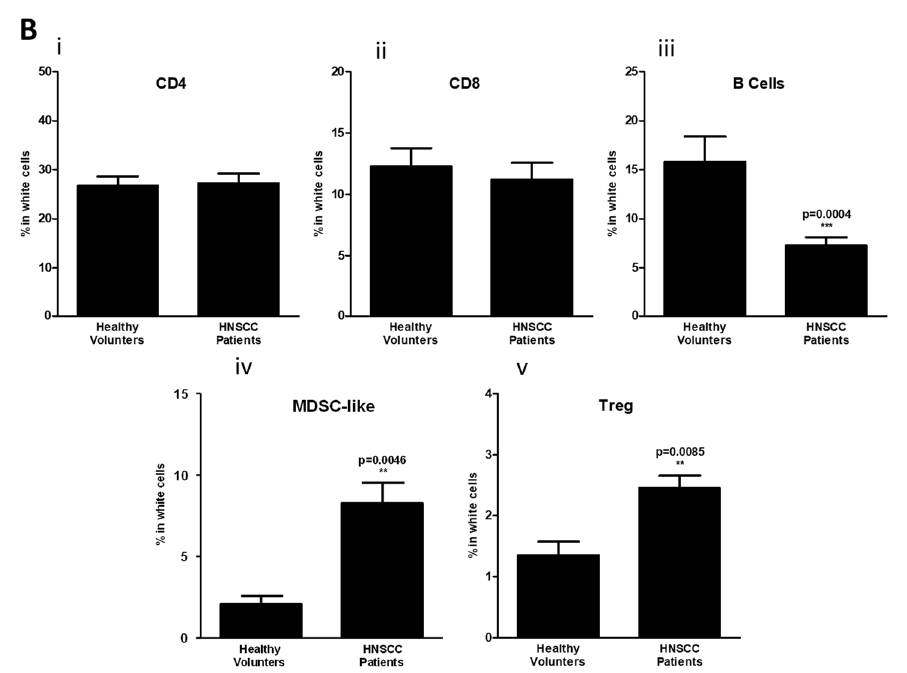
Figure 2. Biospecimen collection and comparison of immunocyte populations in healthy controls and HNSCC patients. ( A ) Outline of study treatments and relative PBMC collection. PBMCs were evaluated at baseline (BASE) prior to treatment and at multiple time points (weeks 3, 6, 21 (3-month), and 52 (1-year)) during and after the completion of concurrent therapy with multicolor flow cytometry (PBMCs) and T-cell receptor sequencing (TCR) studies performed at the time points indicated. ( B ) PBMCs were harvested from healthy volunteers (N = 10) or study patients (N = 35) from baseline draw and flow cytometry performed to determine the relative number of circulating CD4